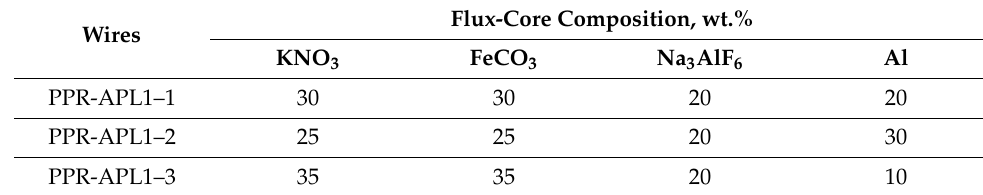
Table 2. The composition of experimental flux-cored wires.